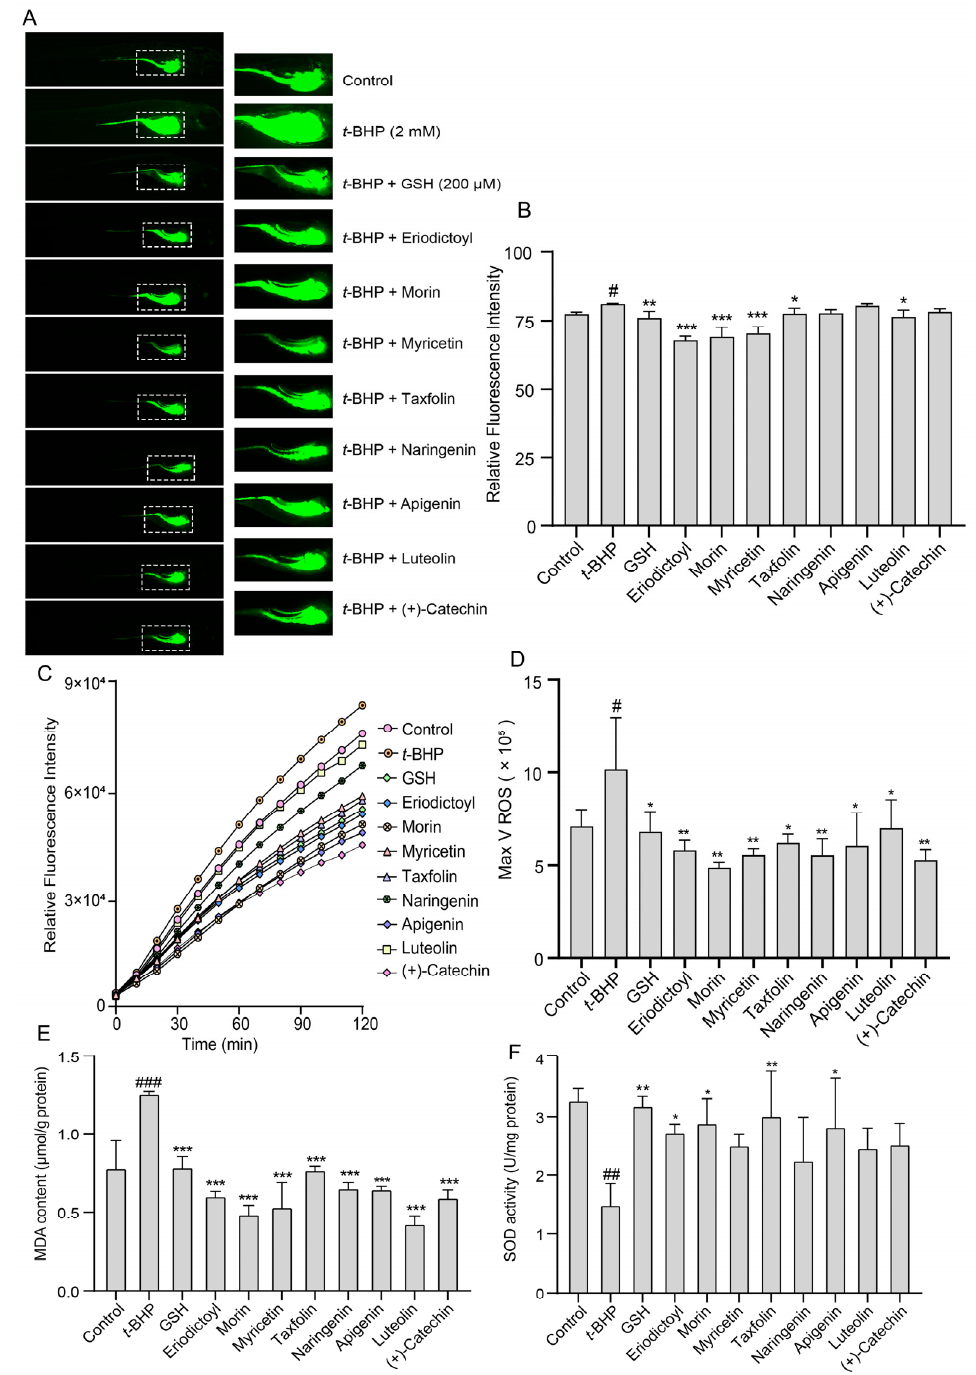
Figure 8. Effect of eight flavonoids on t -BHP-induced oxidative stress in zebrafish. ( A ) The fluores- cence intensity in zebrafish co-treated with eight flavonoids (10 µ M) and t -BHP (2 mM) for 48 h (50 × magnification). ( B ) The quantitative analysis of fluorescence intensity in ( A ). ( C ) The ROS generation was monitored using a fluorescence microplate reader in zebrafish co-treated with eight flavonoids (10 µ M) and t -BHP (2 mM) for 48 h. ( D ) The analysis of ROS maximum generation rate in ( C ). ( E , F ) The MDA content and SOD activity in zebrafish co-treated with eight flavonoids and t -BHP for 48 h ( n = 3). GSH (200 µ M) acts as a positive control. Data were presented as mean ± SD and the statistical differences were analyzed by one-way ANOVA followed by LSD multiple comparisons test (IBM SPSS Statistics 25.0, Armonk, NY, USA). # p < 0.05, ## p < 0.01, ### p < 0.001 vs. the control group. * p < 0.05, ** p < 0.01, *** p < 0.001 vs. t -BHP